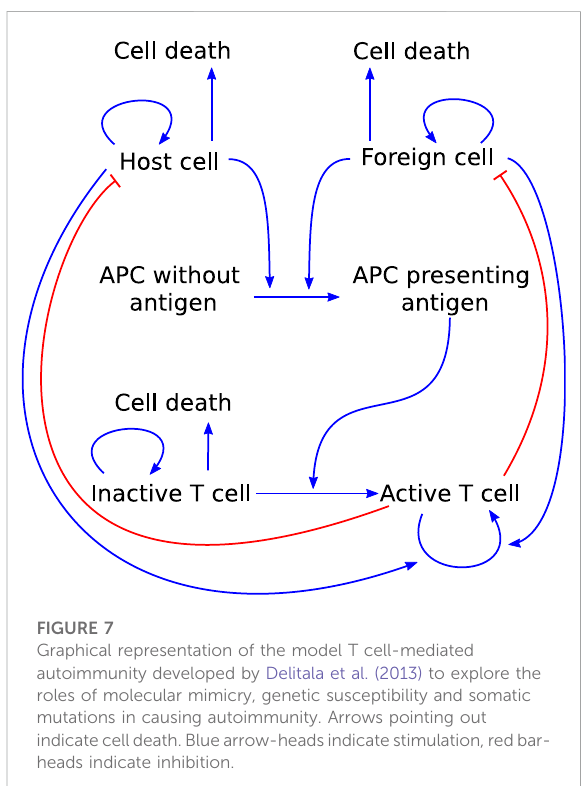
FIGURE 7 Graphical representation of the model T cell-mediated autoimmunity developed by Delitala et al. (2013) to explore the roles of molecular mimicry, genetic susceptibility and somatic mutations in causing autoimmunity. Arrows pointing out indicatecelldeath.Bluearrow-headsindicatestimulation,redbar- heads indicate